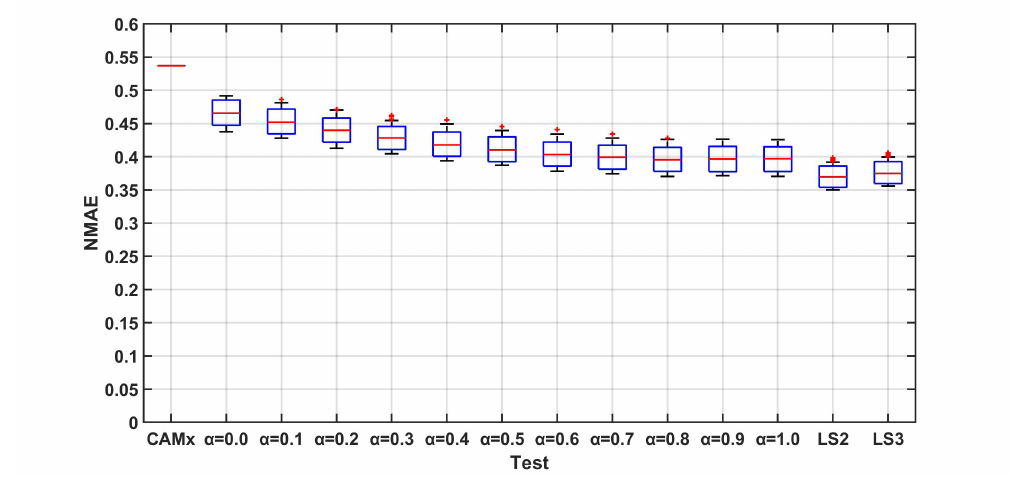
Figure 8. NMAE for the two-step-forward forecast.